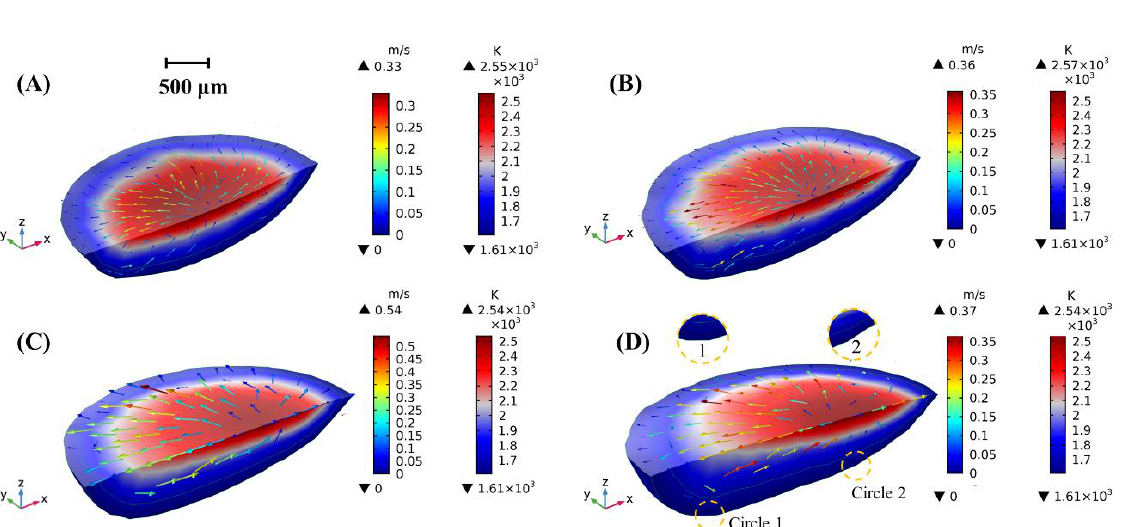
Figure 3. Temperature and velocity distribution at different times: ( A ) 10 ms; ( B ) 50 ms; ( C ) 100 ms; ( D ) 200 ms.